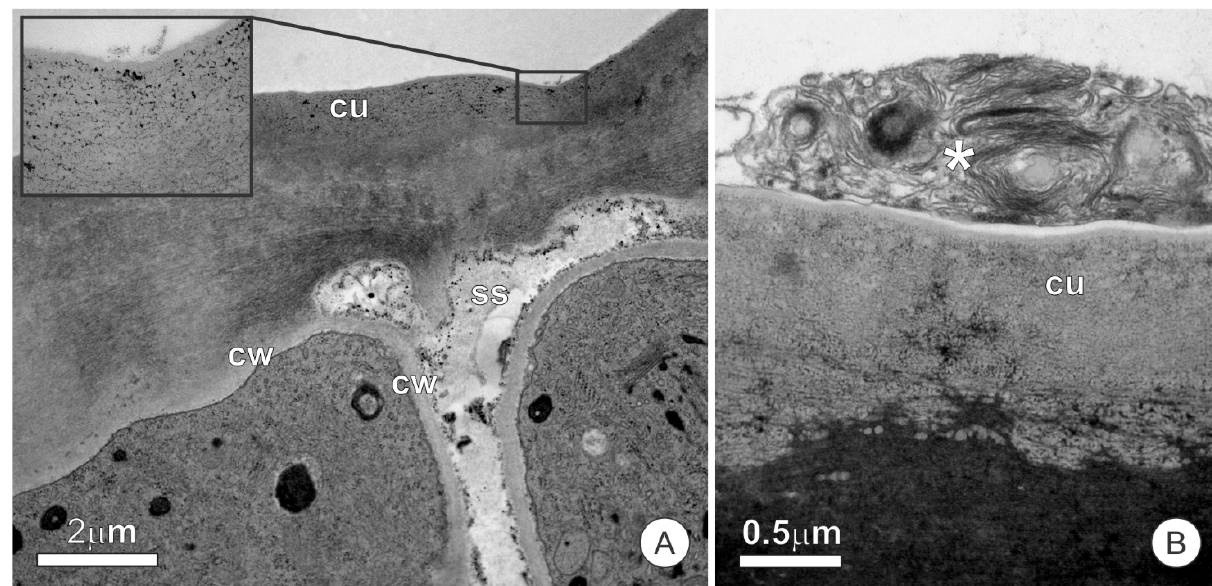
Figure 3. Cuticle structure in the secretory epidermis of resin glands: ( A ) Cross-section of the epidermic cells showing osmiophilic microdeposits inside the cuticle. A small subcuticular space can be observed. ( B ) Secretory residues are forming lamellar structures (*) on the surface of the cuticle. cu = cuticle, cw = cell wall, ss = subcuticular space.